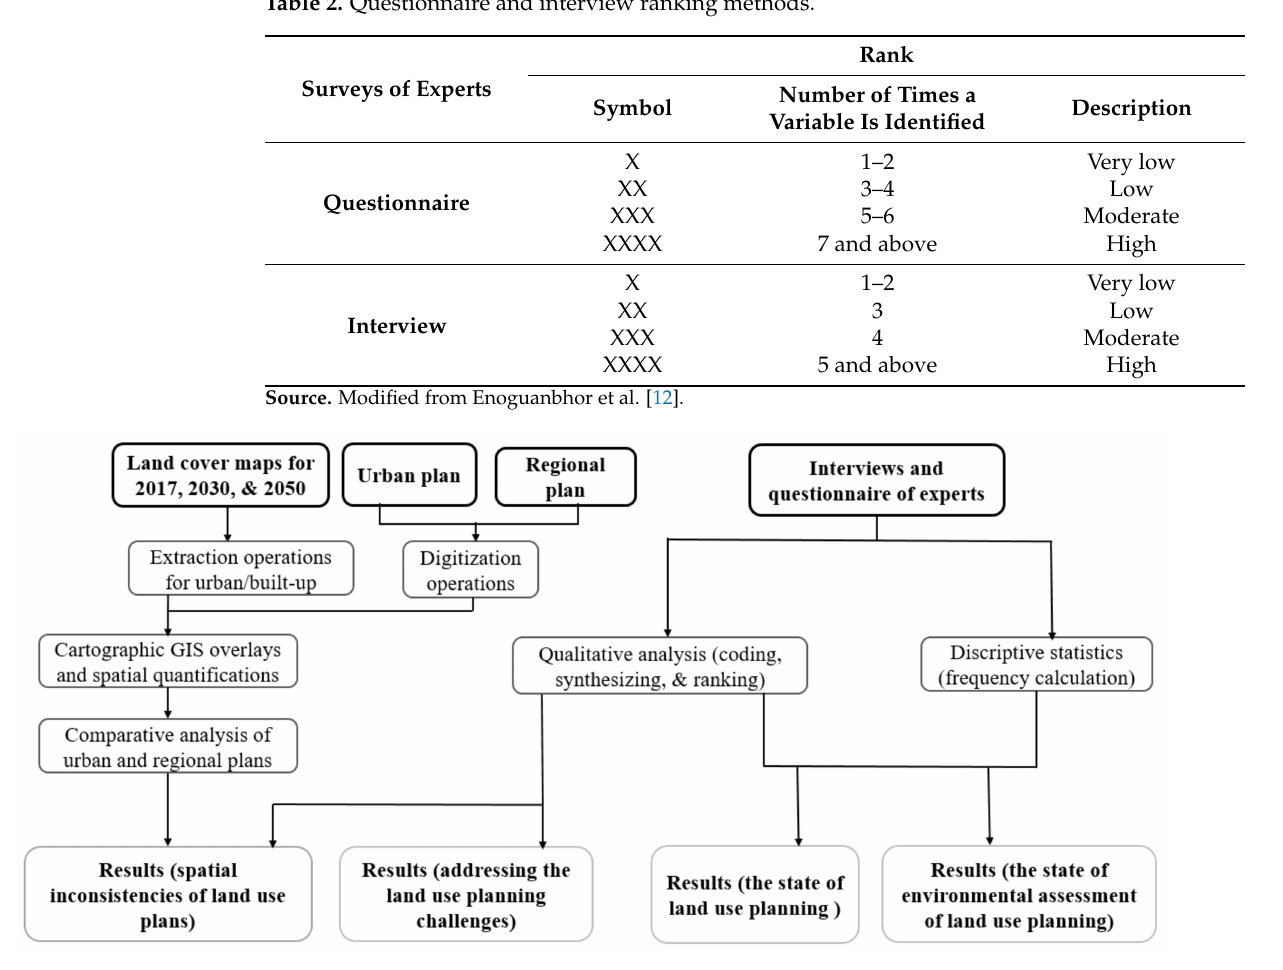
Figure 2. Study workflow showing the mix-methods for key challenges of land use planning and its environmental